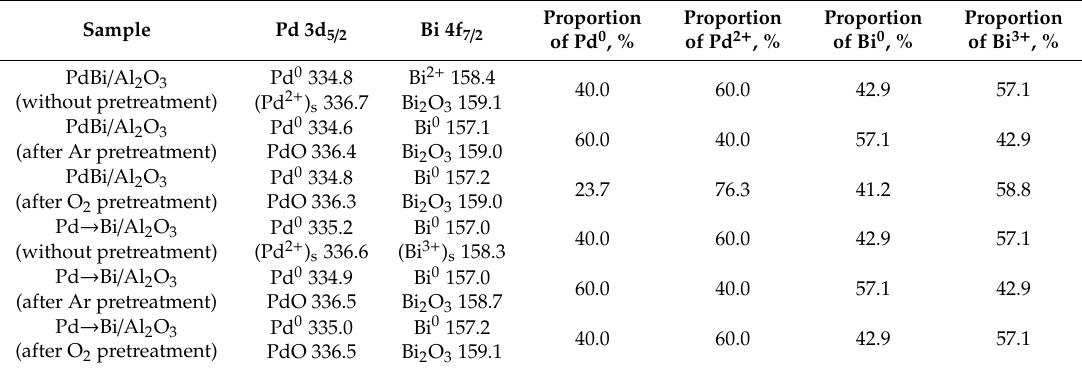
Figure 9. X-ray photoelectron spectra of the Bi 4f line of the catalyst surface after each stage of preparation ( a ) PdBi / Al 2 O 3 , ( b ) Pd → Bi / Al 2 O 3 . Table 4. Binding energy (eV), atomic percentage of Pd, Bi, and the proportion of metal and oxide phases after each stage of catalyst